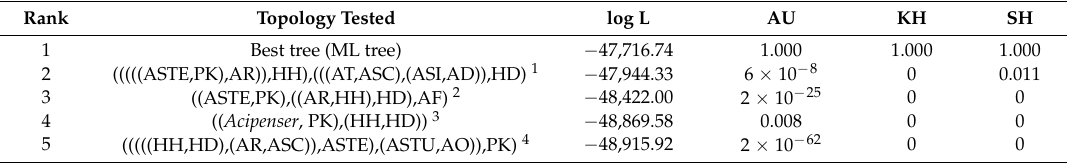
Table 2. Tree topology